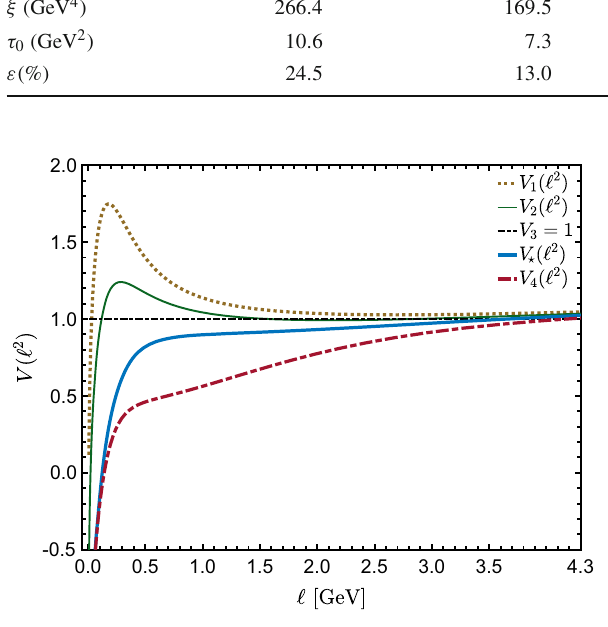
Fig. 4 The five representative cases for V i ((cid:7) 2 ) . All curves are obtained using the the Ansatz given by Eq. (5.9), together with the set of param- eters quoted in Table